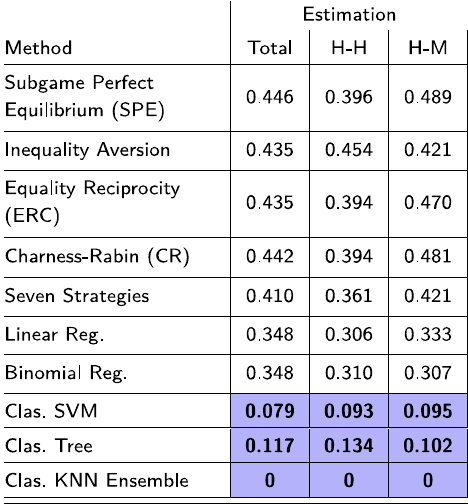
Table 5: Mean squared error for trust and trust ful fi llment: All classi fi cations were run at least initially with all Seven Strategies and interdependence variables. H – H are human – human trust sce - narios and H – M are human – machine. The three best performers along each category are highlighted